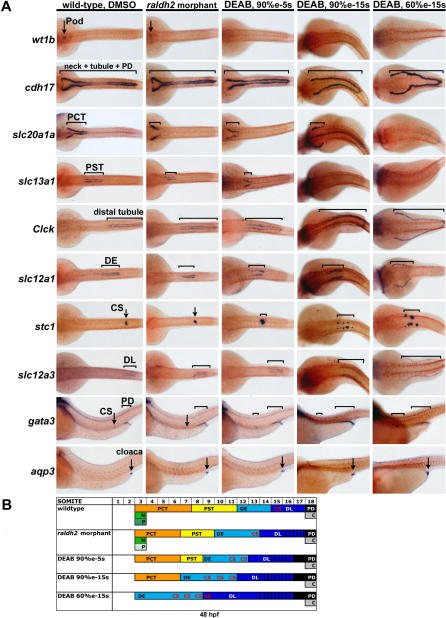
RA Signaling Is Required for Proximal Segment Fates and to Prevent the Expansion of Distal Segment Fates(A) Expression of segment markers and mhc at 48 hpf in wild-type embryos and raldh2 morphants, and wild-type embryos that were incubated with either DMSO (control) or DEAB for indicated times during development, by double whole-mount in situ hybridization. Brackets and arrows indicate expression domains. Abbreviations are: %e (percent epiboly), s (somite stage). Dorsal views are shown, with anterior to the left, with the exception of lateral views for gata3 and aqp3 expression.(B) Summary of nephron segmentation with respect to embryo somite number for each DEAB treatment.